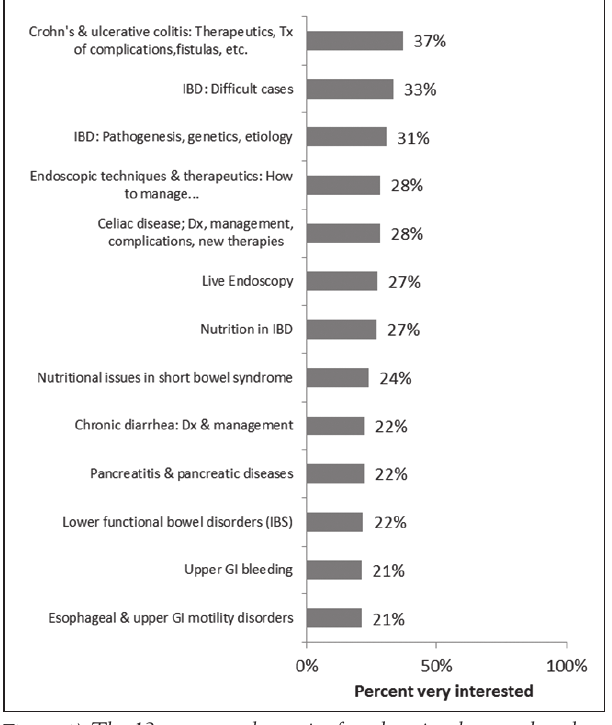
Figure 1) The 13 most popular topics for educational events based on the percent of respondents who were ‘very interested’ in the area. Crohn’s Crohn’s disease; Dx Diagnosis; GI Gastrointestinal; IBD Inflammatory bowel disease; IBS Irritable bowel syndrome; Tx Treatment